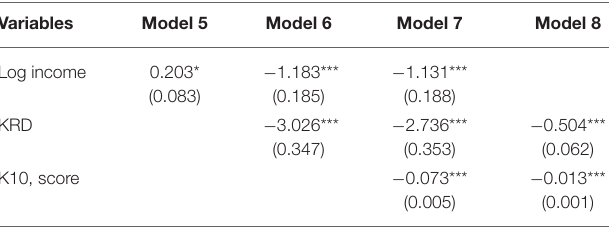
TABLE 3 | Relationship between relative deprivation and SRH in rural older populations (select results) a,b,c .